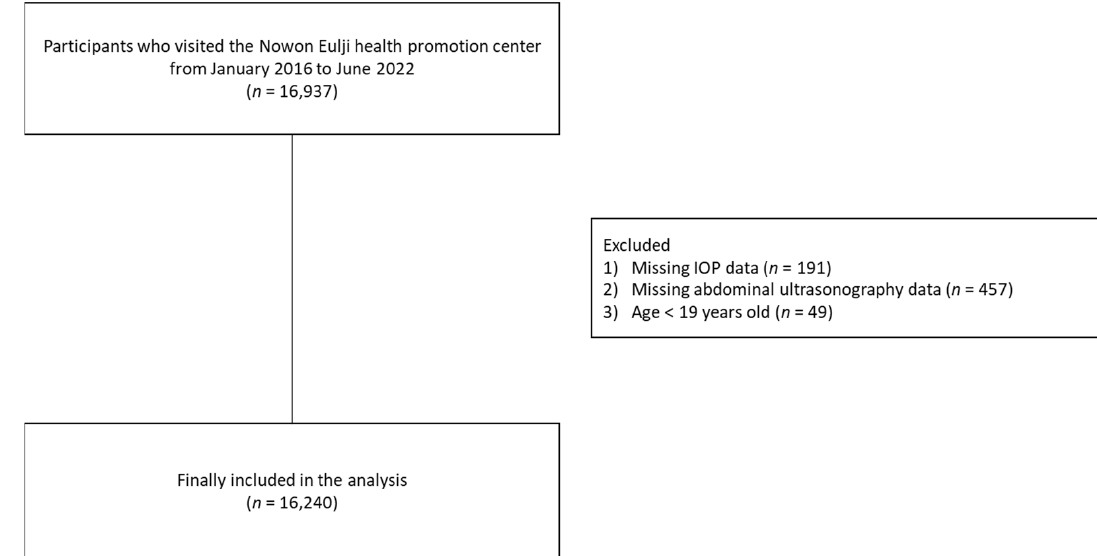
Figure 1. Flowchart of the study population.